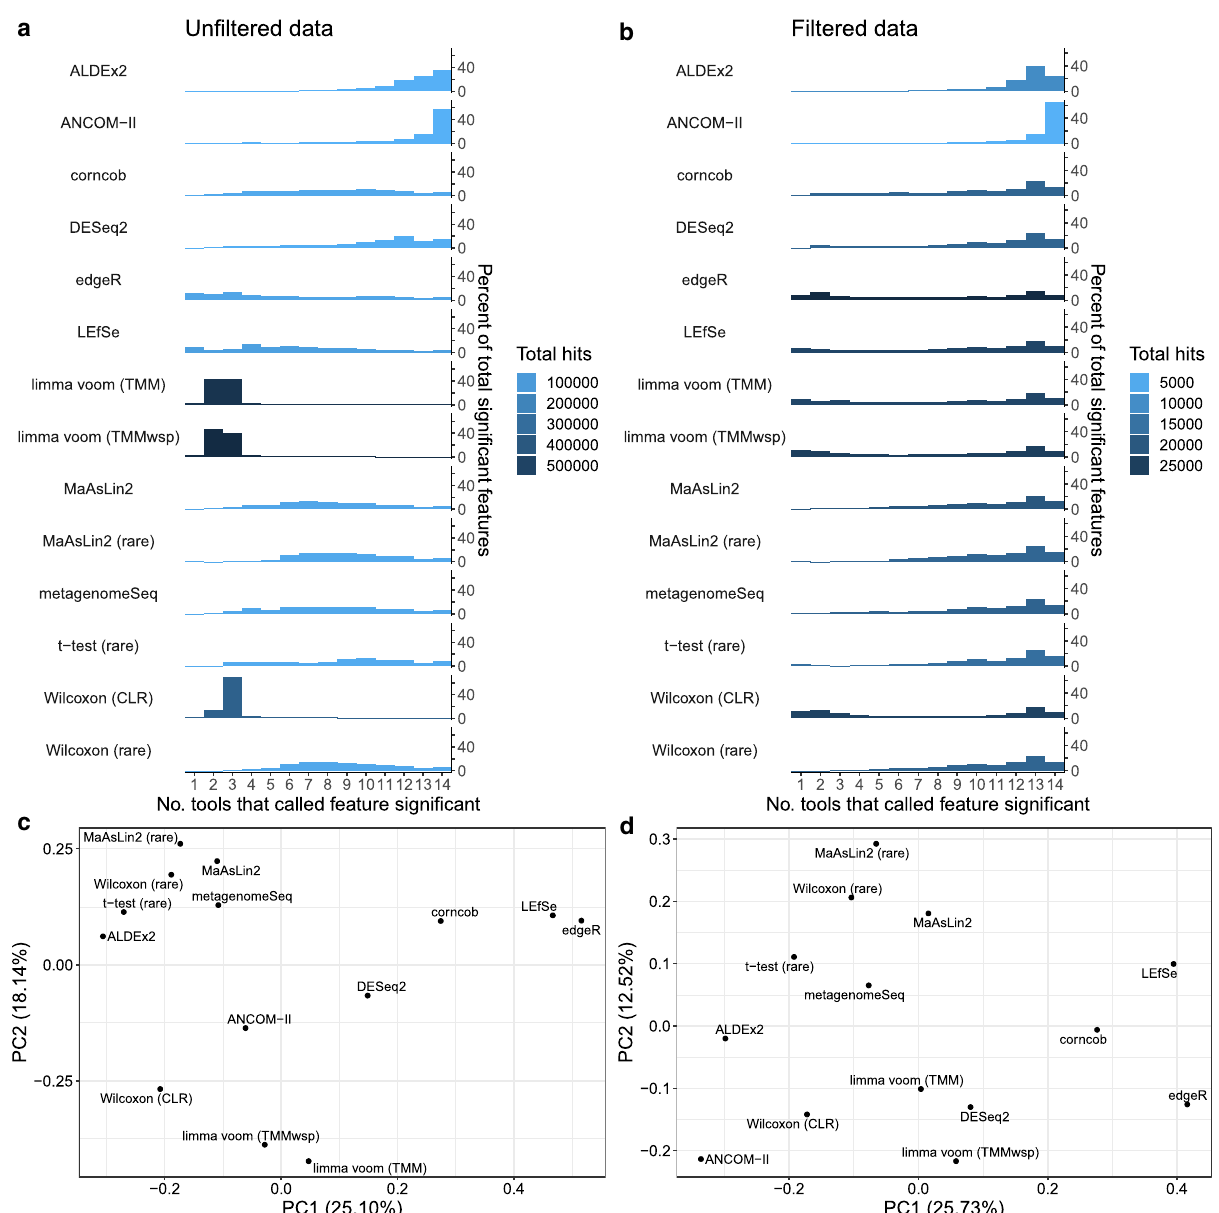
Fig. 3 Overlap of signi fi cant features across tools and tool clustering. a , b The number of tools that called each feature signi fi cant, strati fi ed by features called by each individual tool for the a un fi ltered and b 10% prevalence- fi ltered data. Results are shown as a percentage of all ASVs identi fi ed by each tool. The total number of signi fi cant features identi fi ed by each tool is indicated by the bar colors. For example, based on the un fi ltered data these bars indicate that almost 40% of signi fi cant ASVs identi fi ed by ALDEx2 were shared across all other tools, while ALDEx2 did not identify any signi fi cant ASVs shared by fewer than eight tools. Note that when interpreting these results that they are dependent on which methods were included, and whether they are represented multiple times. For instance, two different work fl ows for running MaAslin2 are included, which produced similar outputs. c , d Plots are displayed for the fi rst two principal coordinates (PCs) for both c non-prevalence- fi ltered and d 10% prevalence- fi ltered data. These plots are based on the mean inter-tool Jaccard distance across the 38 main datasets that we analyzed, computed by averaging over the inter-tool distance matrices for all individual datasets to weight each dataset equally. Abbreviations: TMM, trimmed mean of M-values; TMMwsp, trimmed mean of M-values with singleton pairing; rare, rare fi ed; CLR, center-log-ratio. Source data are provided as a Source Data fi